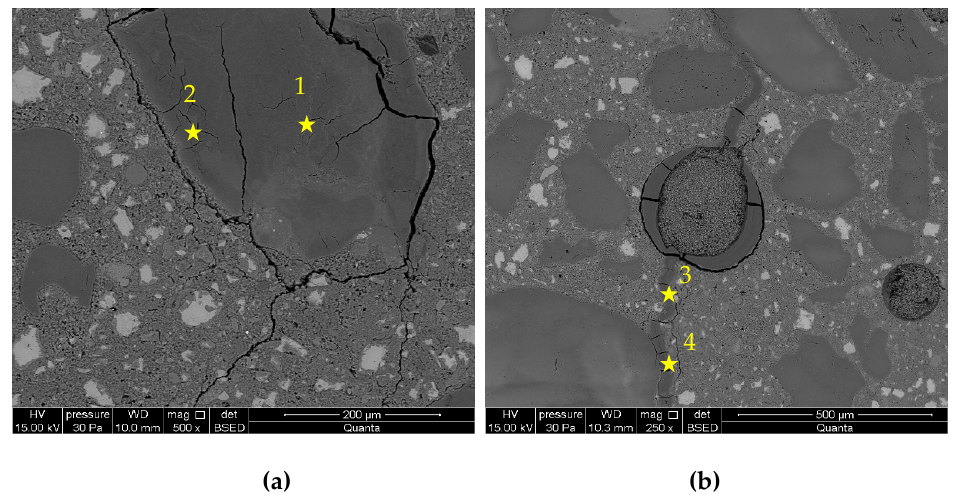
Figure 8. Microstructure images of mortars with10% of metakaolin: ( a ) ASR gel in aggregate; ( b ) ASR gel in cement paste. X-ray microanalysis at location 1 – 4 (see Table 4).